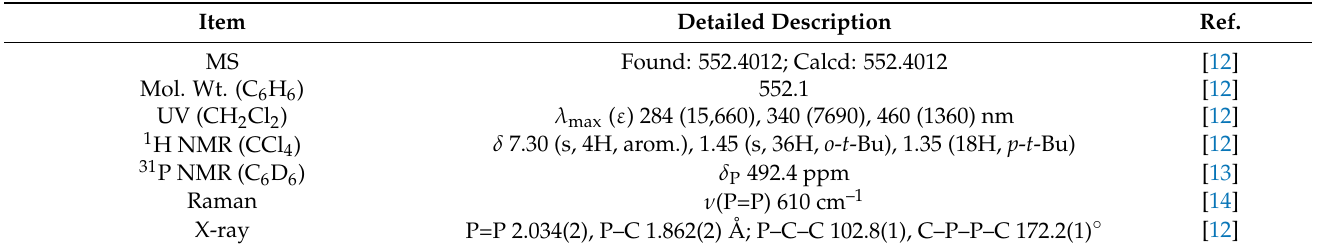
Table 1. Some physical data of diphosphene 17 .